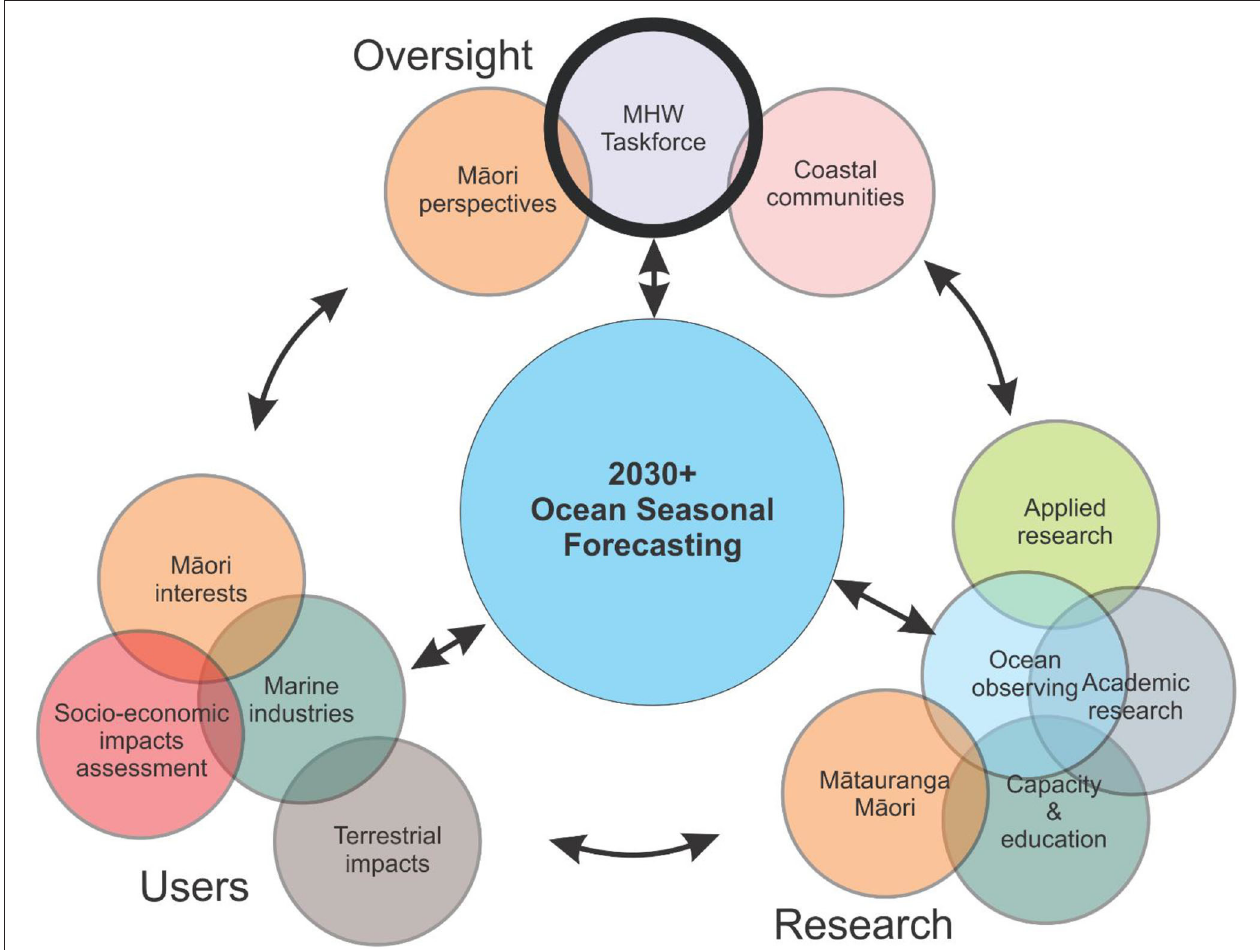
FIGURE 2 | Ocean Seasonal Forecasting (OSF) for 2030 + centered view of the research-delivery ecosystem showing interest-clusters. These are classed as (top) oversight interests, (lower left) end-user needs/impacts and (lower right) research/forecast/knowledge community.